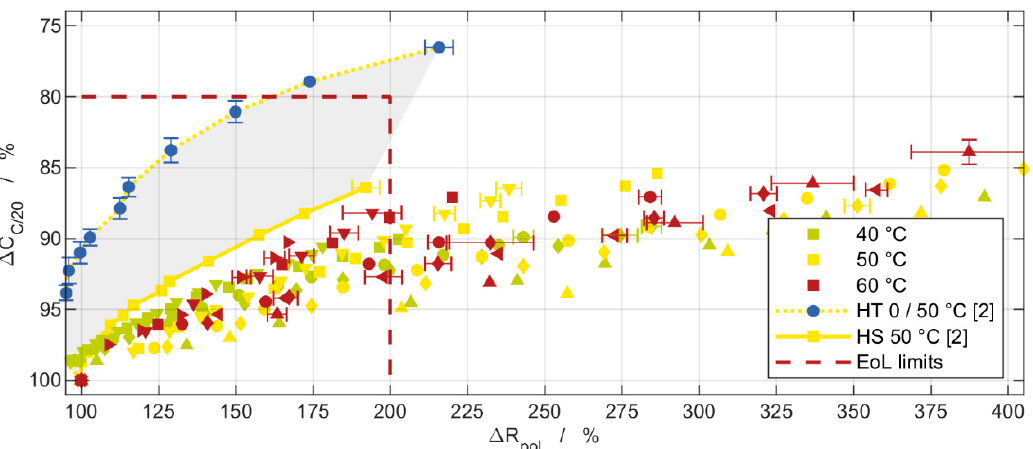
Figure 11. Capacity fade versus power fade in terms of polarization resistance increase in all storage aging conditions compared to range of the results from the cyclic aging study. The coloring and line style of HT 0/50 °C and HS 50 °C are taken from [2]. The designated EoL limits are indicated as dashed red square while the BoL state is located in the lower-left corner.